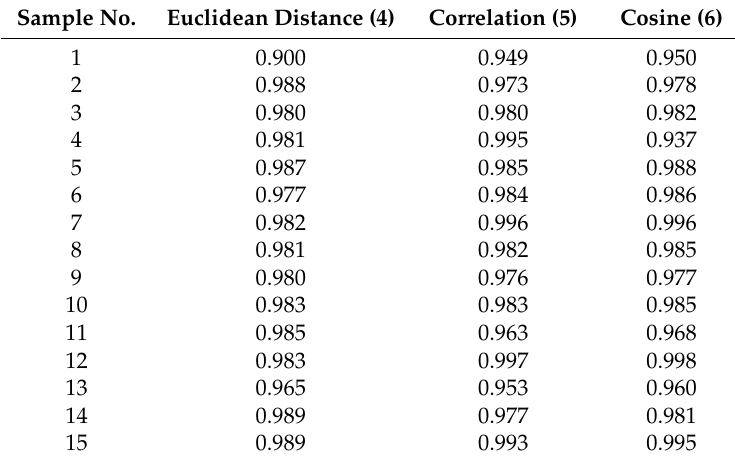
Figure 6. Results of hierarchical clustering analysis ( A ); and principal components analysis ( B ) of the 15 samples of Ilex kudingcha C. J. Tseng. Table 9. Similarity analysis results of 15 samples from different